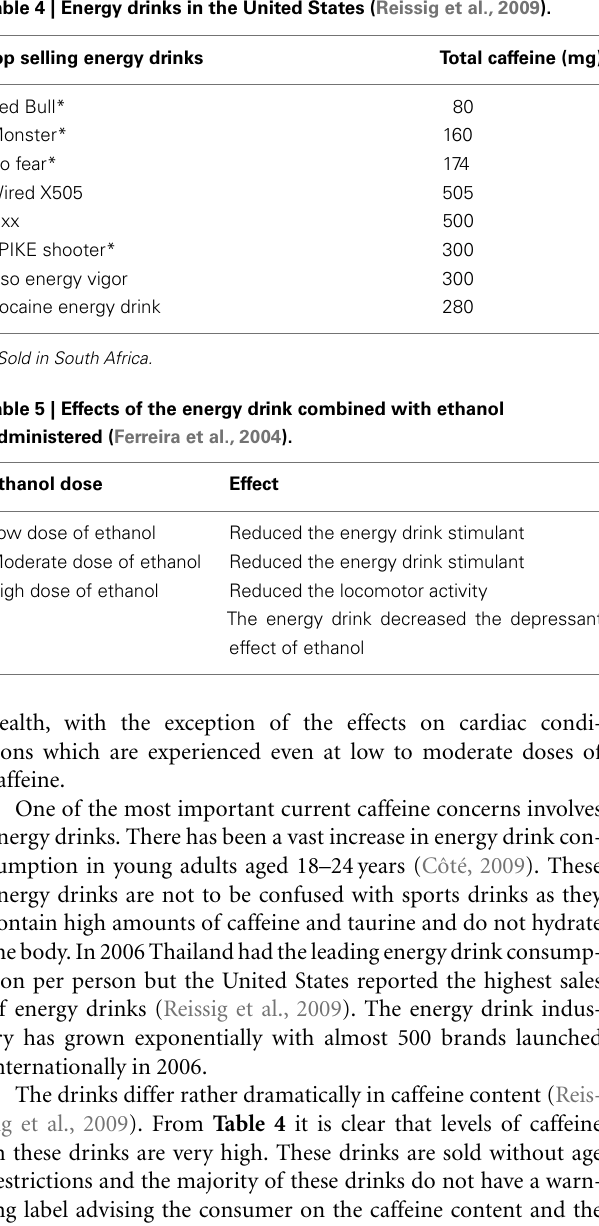
Table 4 | Energy drinks in the United States (Reissig et al., 2009).